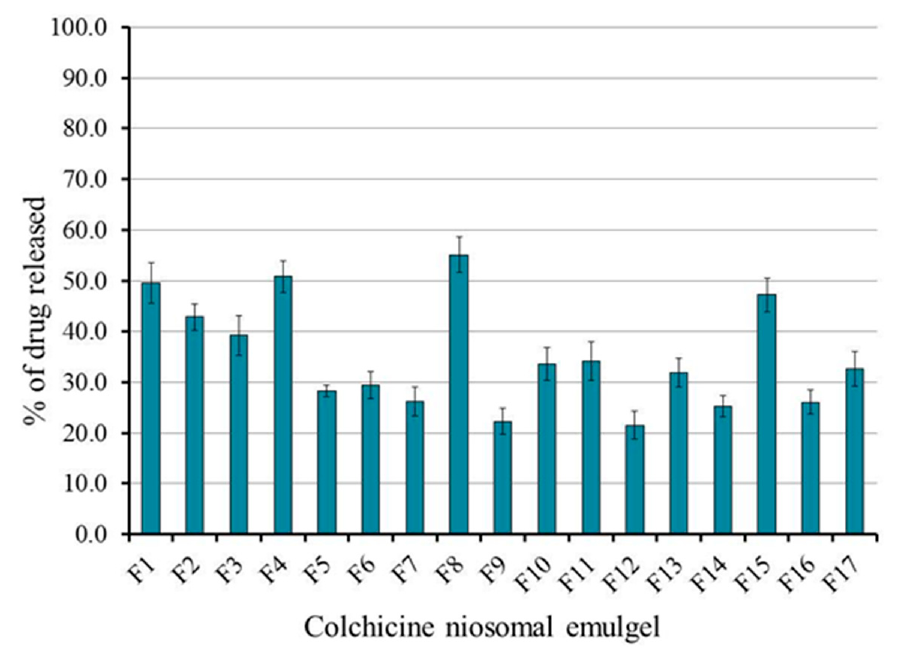
Figure 6. In vitro release of colchicine from different niosomal emulgel formulations maintained at 37 °C using phosphate buffer pH 7.4 following 6 h. Results are expressed as mean ± SD of three experiments.